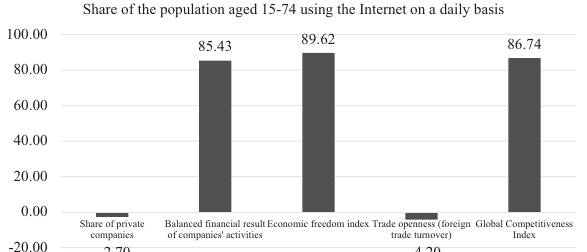
Fig. 4 Correlation between Russian ‘ capitalism 4.0 ’ and the share of the population using the Internet on a daily basis (%). Source: Calculated by the authors.